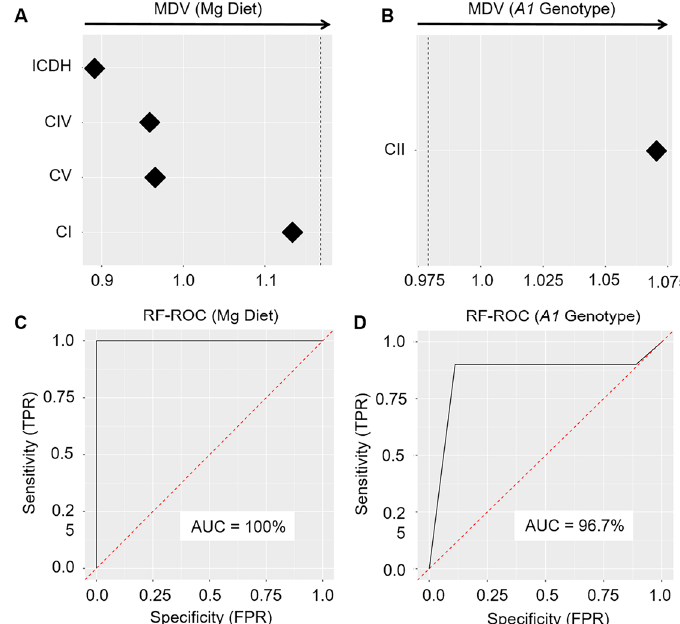
Figure 9. Importance plots depicting prioritization of selected predictors according to their discriminative ability between the types of Mg diet (LMgD vs. NMgD; A ) or the Slc41a1 genotypes ( Slc41a1 − / − vs. Slc41a1 +/+ ; B ). In panela A and B, the dashed lines separates the well-suitable predictors (left from the line) from the less-suitable predictors (right from the line). ROC (receiver operating characteristic) curves with the area under the ROC curve (AUC) for RFM-L algorithm with ( C ) ICDH, CI, CIV, and CV as joint predictors of the type of Mg diet, and with ( D ) CII as predictor of the Slc41a1 genotype. Abbreviations: A1 , Slc41a1 ; FPR, false positive rate; MDV, minimal depth of a variable; RFM-L, random forest machine-learning; TPR, true positive rate.